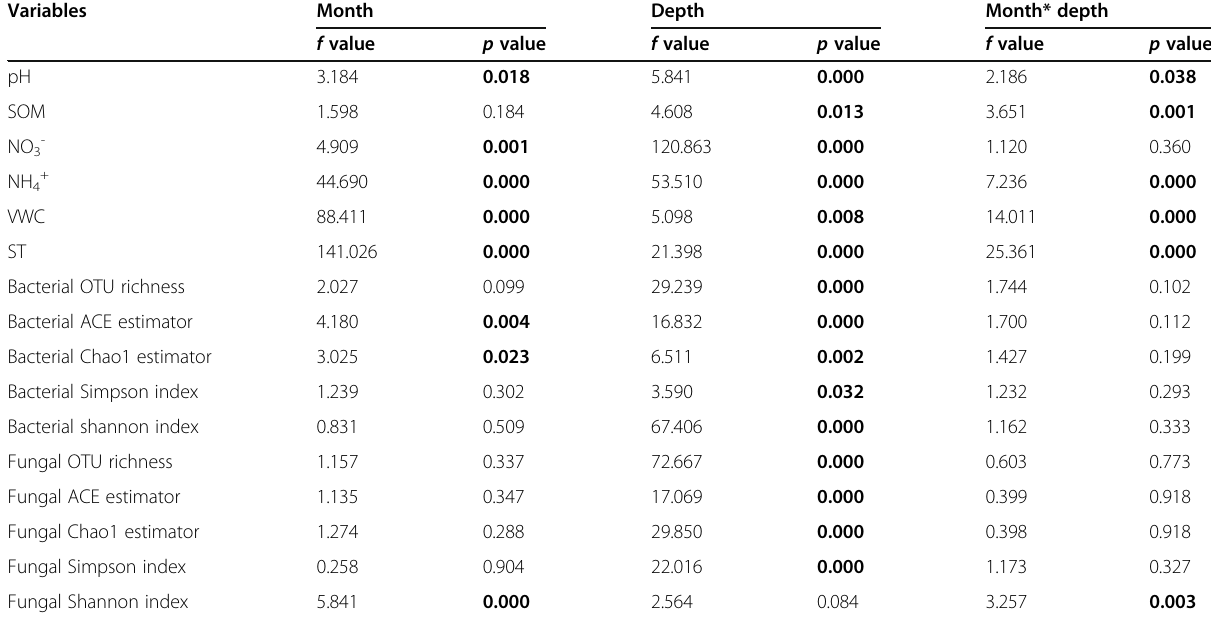
Table 1 Multivariate analysis of soil properties and microbial community α -diversity index (two-way ANOVA) Variables Month Depth pH